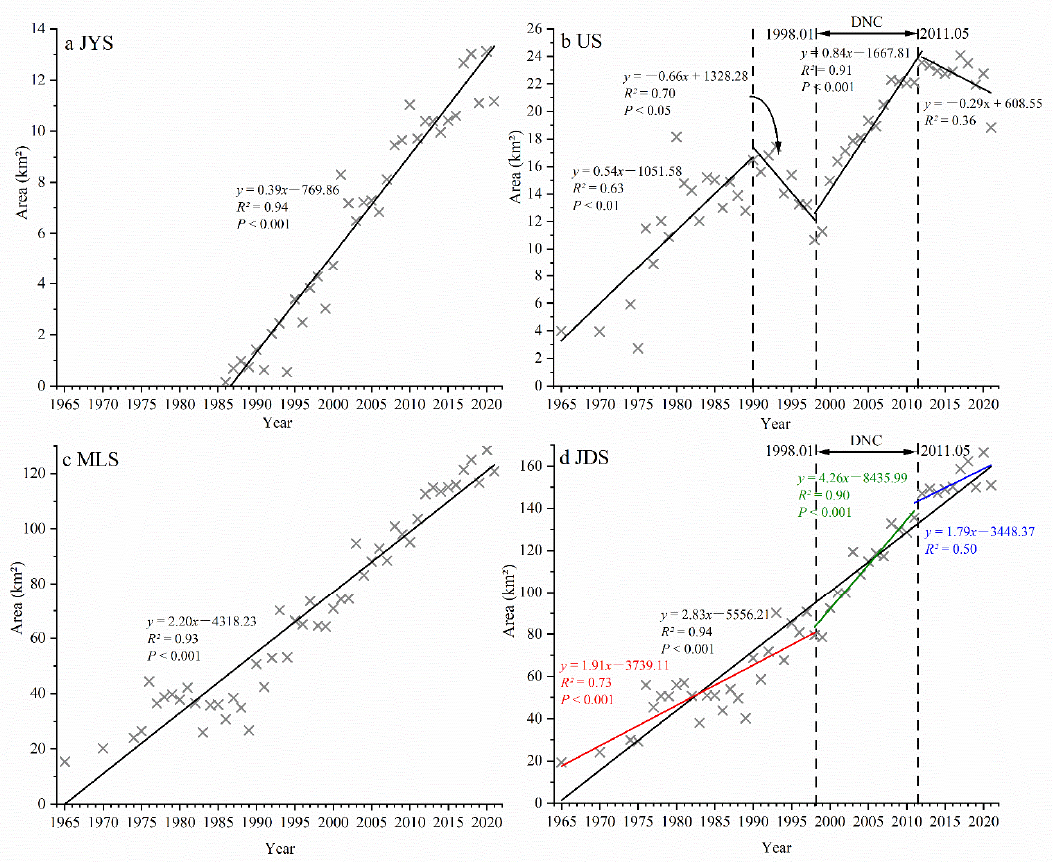
Figure 5. Exposed area variation of low tidal flats in ( a ) the JYS, ( b ) the US, ( c ) the MLS and ( d ) the JDS.